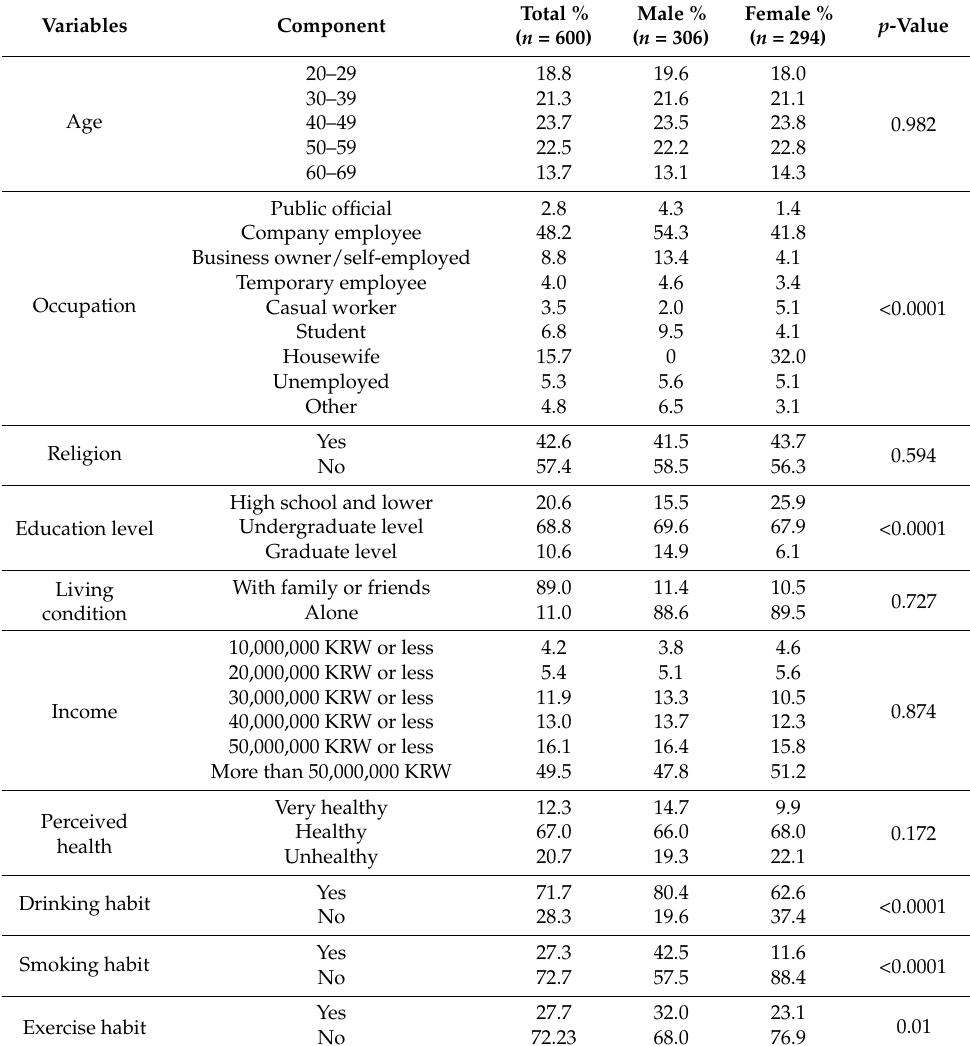
Table 1. The sociodemographic characteristics, health behavior, and sleep behavior of the study population stratified by